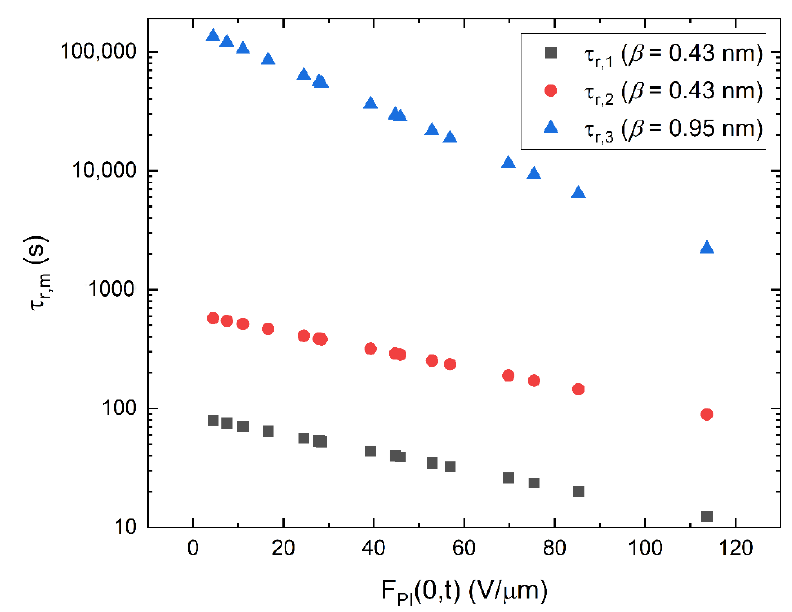
Figure 9. Release time ( τ r , m ) plotted as a function of the instantaneous field at the ITO/PI interface ( F PI ( 0, t ) ). For the deepest level of traps at 1.0 eV ( τ r ,3 ), a stronger field dependence, compared to the other levels, yielded a more accurate fit between experimental and simulated data.